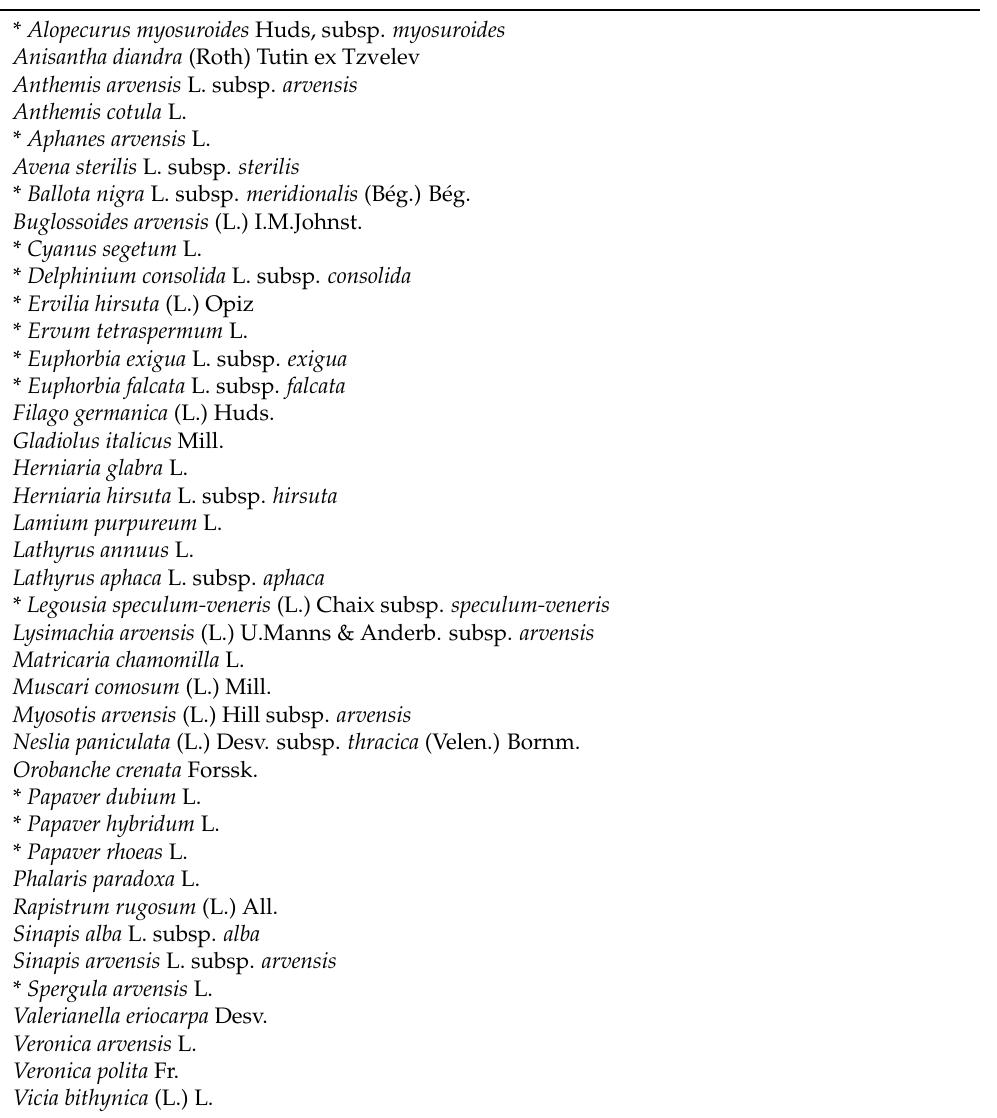
Table 1. Strictly (marked with an asterisk) and characteristic segetal species occurring in the territory of Appia Antica Regional Park (names in alphabetical